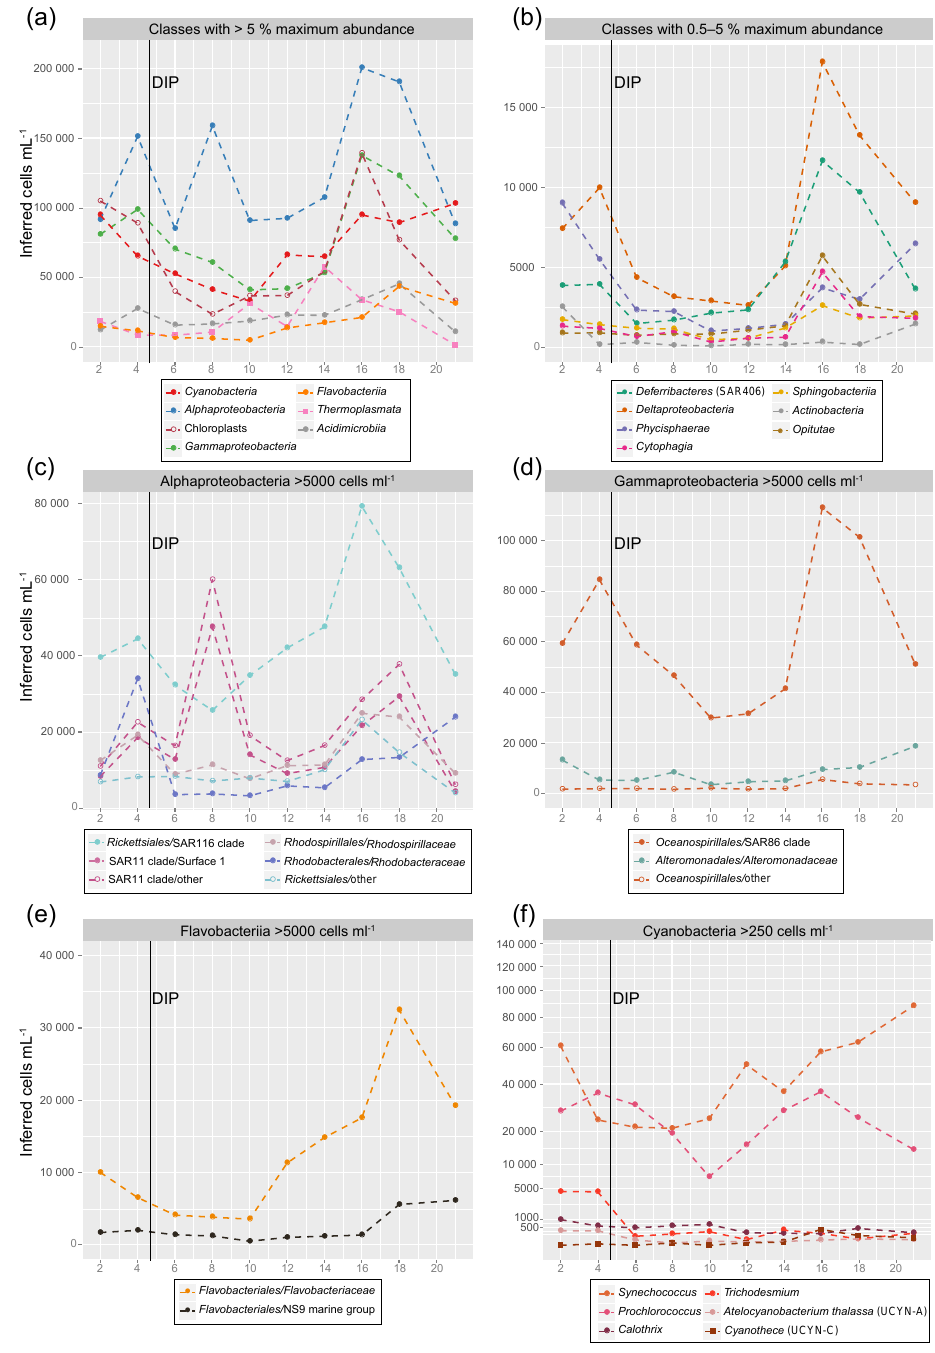
Figure 3. Evolution of the 16S community with time for surface samples (1m depth) inside mesocosm M1. Absolute abundances incellsmL − 1 were inferred in three calculation steps. Initially, raw read counts per OTU were normalized to equal 16S copy numbers (“16S-norm reads”). These reads were summed for all Prochlorococcus (Pro) and Synechococcus (Syn) OTUs in each sample and divided by the sum of flow cytometry cell counts for Syn and Pro in that sample, creating a ratio. For each OTU, the 16S-norm read count was then divided by this ratio to produce the inferred absolute abundance of that OTU. This procedure accounts for library size in each sample. For better visualization, the classes with (a) a maximum abundance above 5% and (b) a maximum abundance between 0.5 and 5% were plotted separately. (c–e) Families with >5000cellsmL − 1 (at their respective maximum) amongst the dominant non-photosynthetic classes Alphaproteobacteria , Gammaproteobacteria , and Flavobacteriia . (f) All genera with >250cellsmL − 1 (at their respective maximum) within photosynthetic Cyanobacteria . Dashed lines were used to connect the data points for visualization purposes only. The DIP fertilization event in the evening of day 4 is indicated by a black vertical